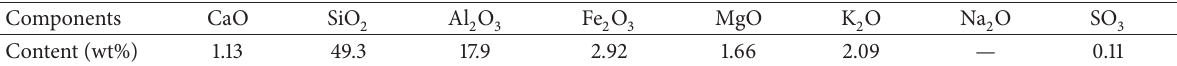
Table 1: Chemical composition of CWBP.